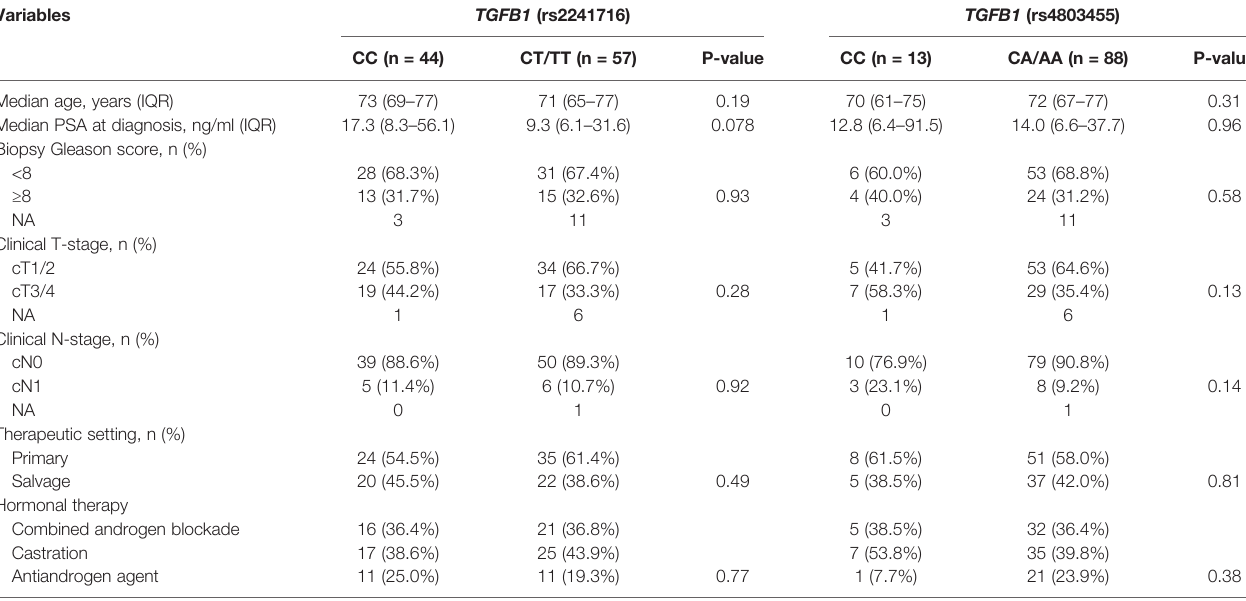
TABLE 1 | Clinicopathological characteristics of patients with non-metastatic prostate cancer according to TGFB1 polymorphisms. Variables